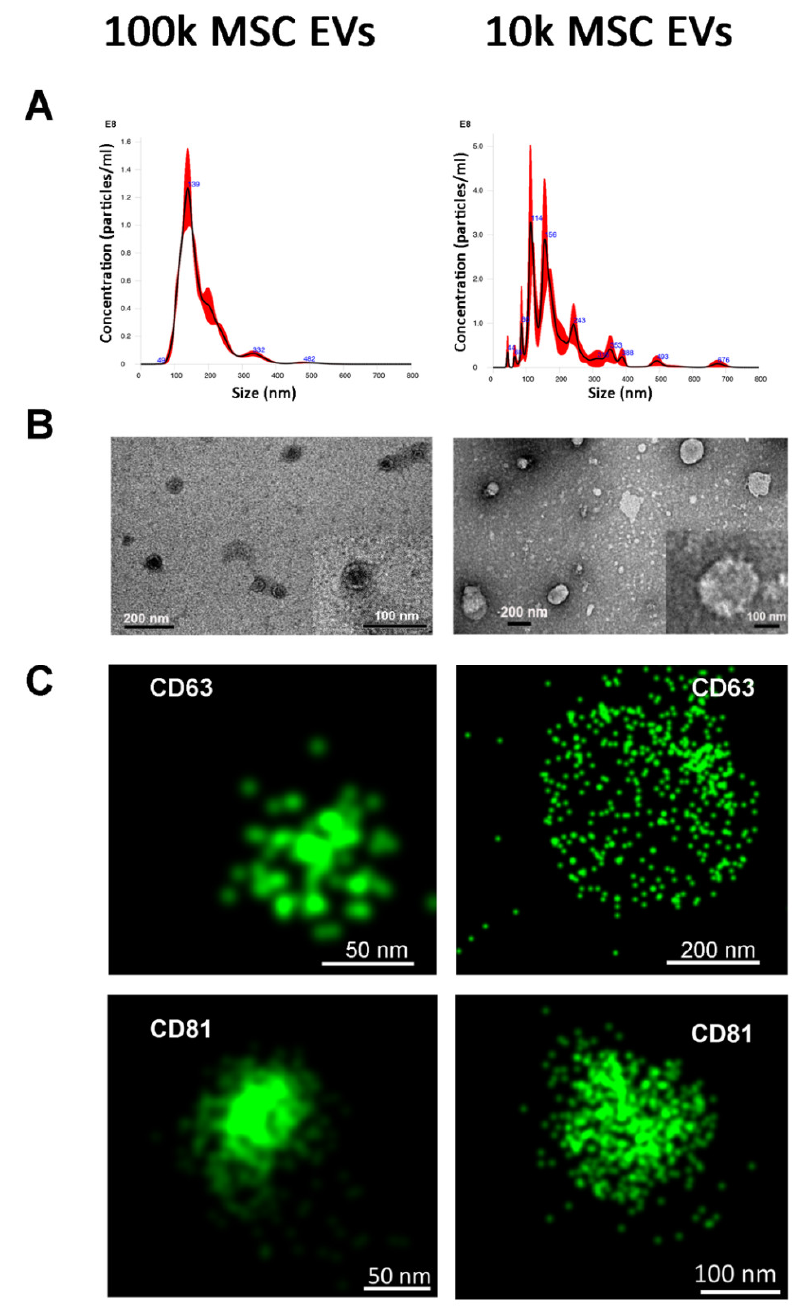
Figure 2. Characterisation of 100k and 10k naive MSC EVs. ( A ) Representative graphs of nanoparticle tracking analysis of 100k MSC EVs (left panel) and 10k MSC EVs (right panel). ( B ) Representative images of transmission electron microscopy of 100k MSC EVs (left panel) and 10k MSC EVs. The corresponding scale bare is below each EV image. ( C ) Representative super-resolution microscopy images of 100k MSC EVs (left panel) and 10k MSC EVs (right panel) stained with CD63 or CD81 tetraspanins. In addition, no differences were detected in the size of the 100k EVs in respect to the 10k EV fractions using this technique. In contrast, by electron microscopy, the majority of 100k EVs were smaller than 100 nm, whereas the majority of 10k EVs were in a size range of 100–300 nm (Table